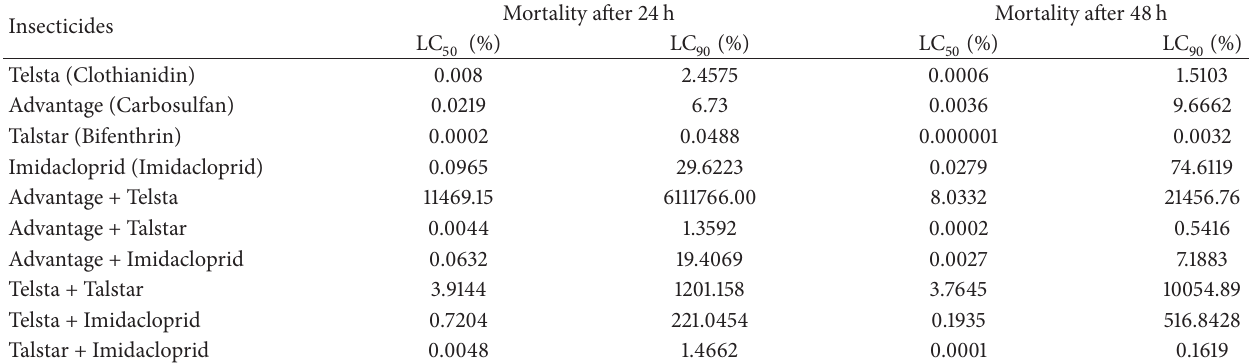
Table 1: LC 50 and LC 90 values of different insecticides against hibiscus mealybug, M. hirsutus, after 24 and 48 h of application in laboratory bioassay.